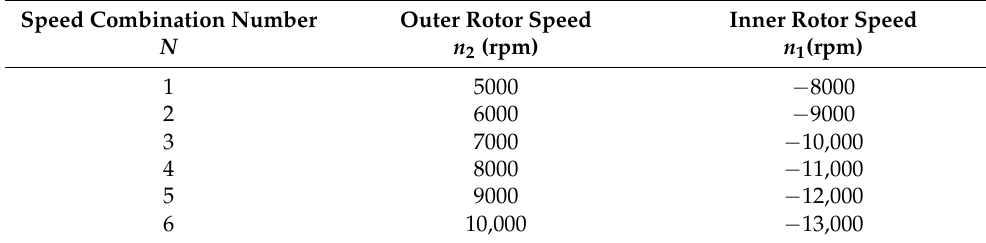
Table 5. Synchronous changes in outer and inner rotor speed.